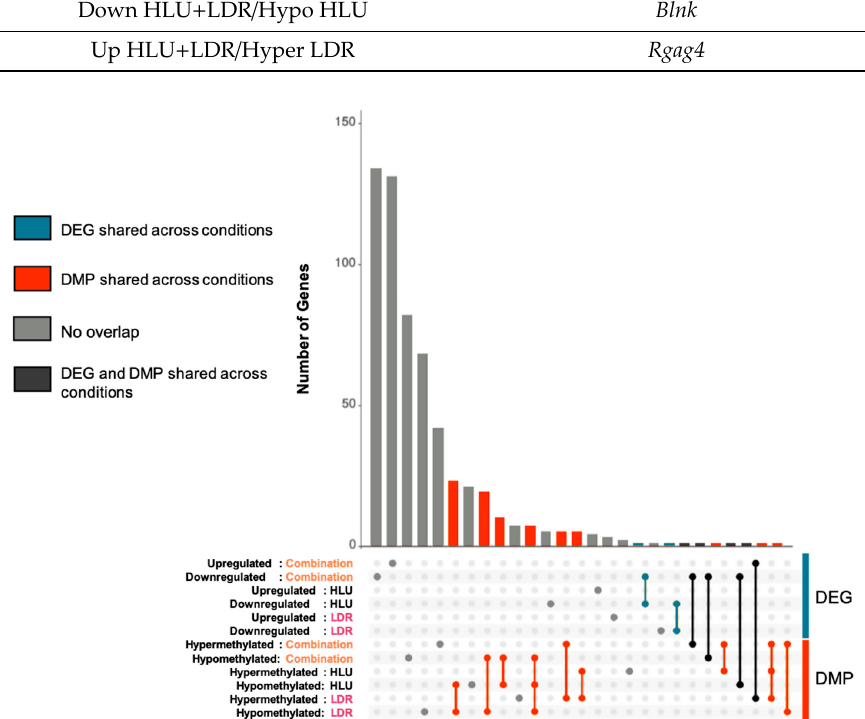
Figure 4. Minimal brain di ff erential gene expression and promoter methylation overlap across di ff erent simulated spaceflight experimental conditions. Gene lists of DEGs and the genes corresponding to the di ff erentially methylated promoters (DMPs) were created for each condition: LDR, HLU, or HLU + LDR combined versus controls. The dotted region depicts all conditions, and the connecting lines depict DEG / DMP overlap between experimental conditions. The vertical bars indicate the size of that overlap. A single, grey dot indicates the number of DEG / DMP that do not overlap with any other DEG / DMP. The red dots indicate DMP overlap across di ff erent conditions. The blue dots indicate DEG overlap across di ff erent conditions. The black dots indicate DEG and DMP overlap. “Upregulated / downregulated” denotes gene expression of DEG and “hypermethylated / hypomethylated” denotes methylation patterns of DMPs.